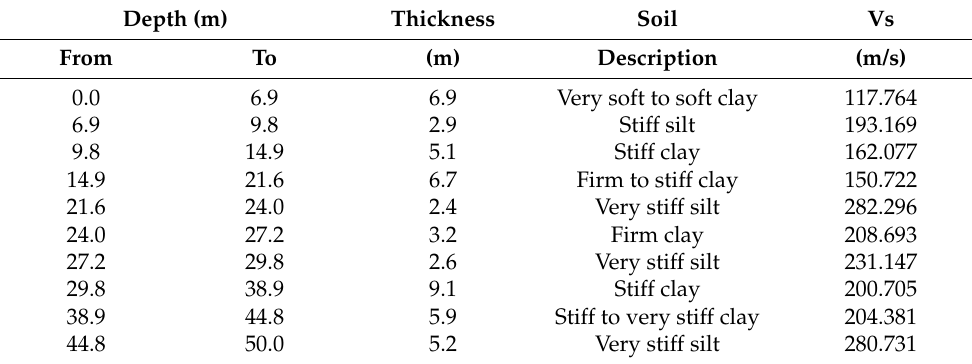
Table 2. Soil model for D1 used in the present study.